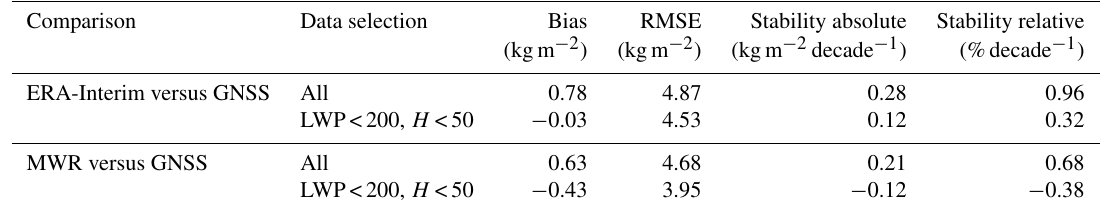
Figure 6. Validation statistics for WTC sea surface height variability. Data shown here are for Envisat only. (a) and (c) show comparisons against WTC derived purely from ERA-Interim. (b) and (d) show comparisons against the operational WTC retrieval from Envisat. (a) and (b) show globally averaged monthly statistics. (c) and (d) show long-term spatial statistics. Values smaller than zero indicate an improvement. Values larger than zero indicate a deterioration of the results relative to the comparison dataset. Table 2. Summary of comparisons between ERA-Interim versus GNSS and MWR versus GNSS in terms of bias, RMSE, and stability of the